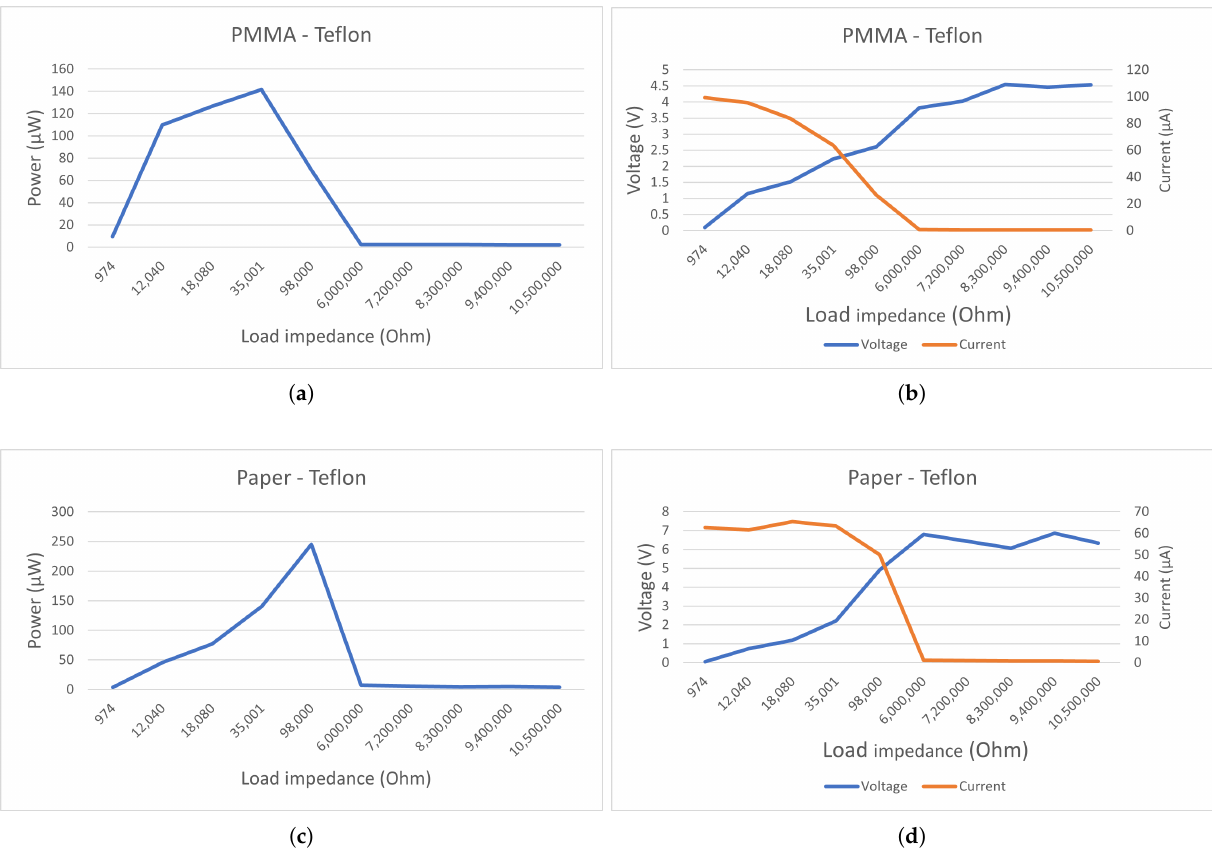
Figure 17. Converted power versus load resistance from PMMA-Teflon ( a ); Output current/voltage for different loads from PMMA-Teflon ( b ); Converted power versus load resistance from Paper-Teflon ( c ); Output current/voltage for different loads from PMMA-Teflon ( d